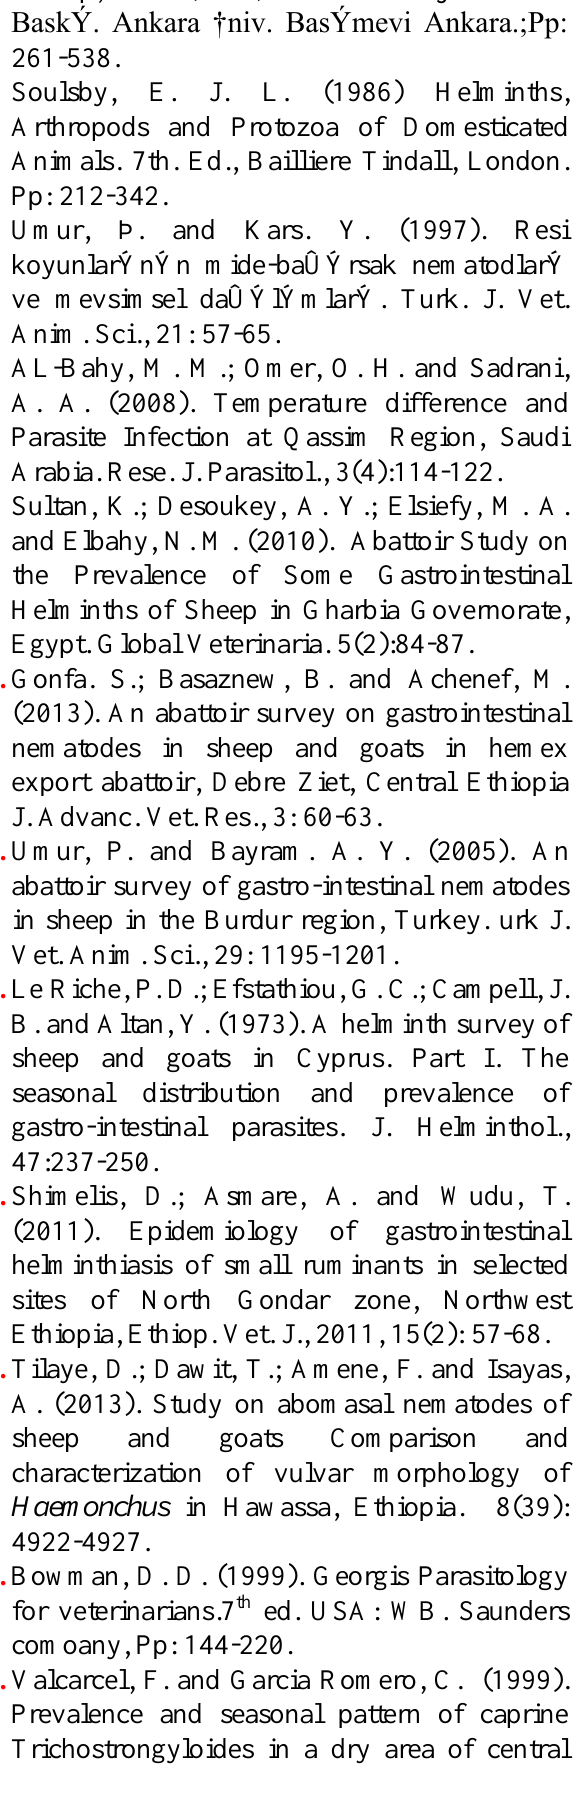
% of No. of No. of infected infected samples samples